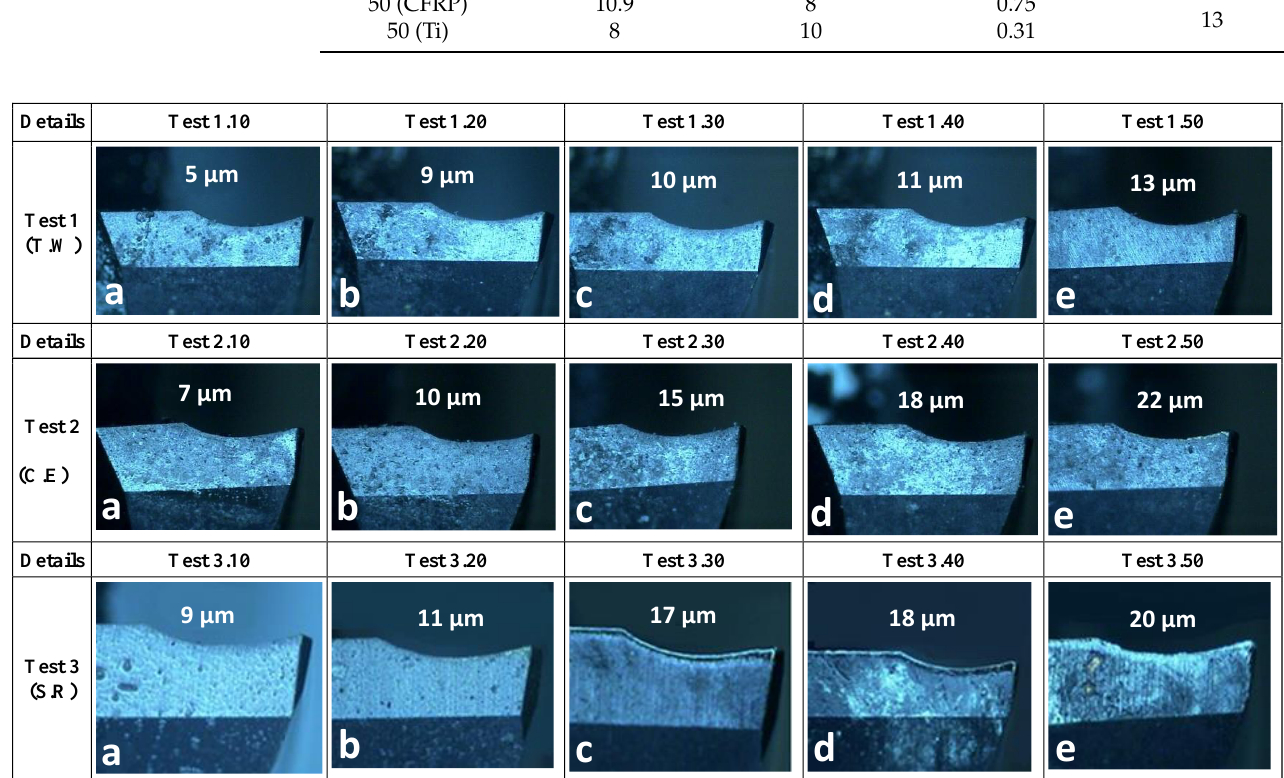
Figure 16. Tool wear analysis of confirmatory experiments: Test 1: SS CFRP 7500 rpm, SS Ti 1000 rpm,